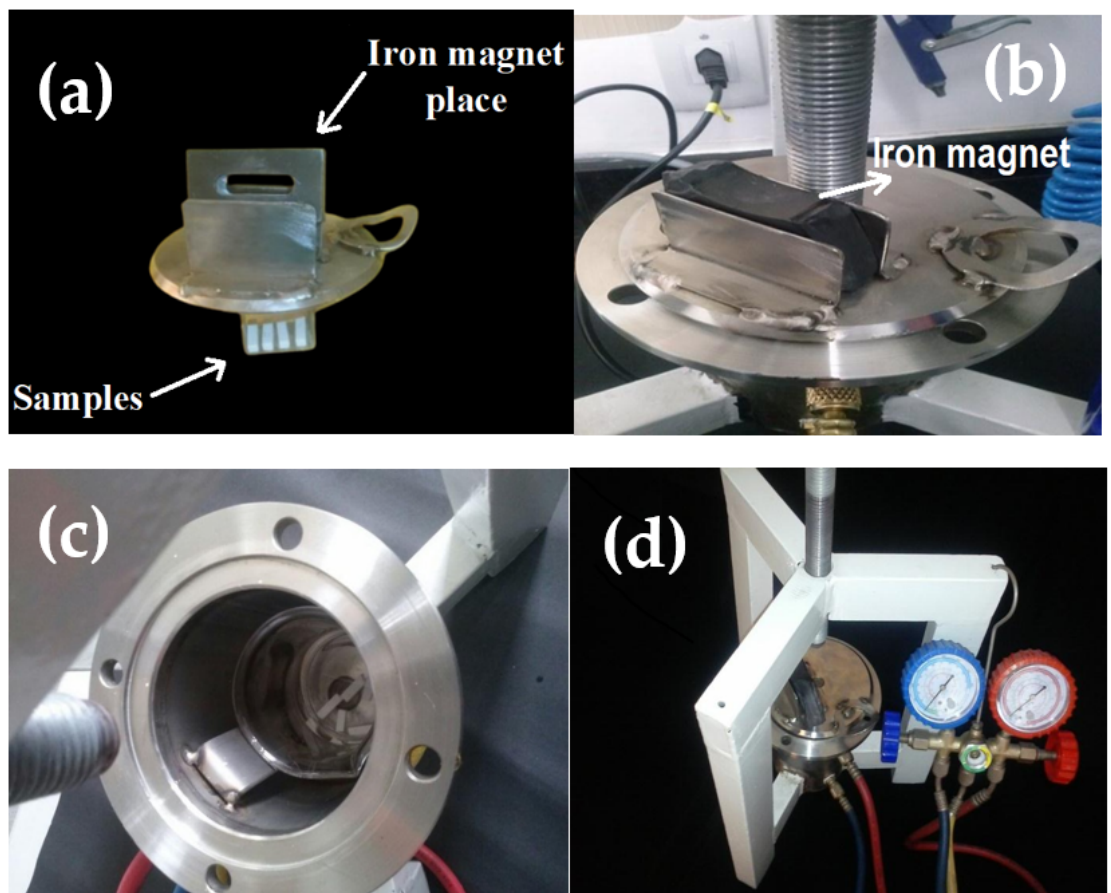
Figure 2. Configuration of the homemade system designed for infiltration of PMMA into the sintered Al 2 O 3 commercial samples. ( a ) A lid of the stainless steel for vacuum chamber above which one iron magnet is placed, ( b ) iron magnet (150 mm × 60 mm × 15 mm; mass = 60 g) put over the lid, ( c ) a stainless steel vacuum chamber (diameter = 170 mm, height = 230 mm and thickness = 6 mm) inside which a beaker and samples are shown, and ( d ) the whole configuration of infiltration system connected to vacuum pressure adjustment. Table 1. Summary of conditions for preparation of samples, infiltration time and the estimated amount of PMMA (vol.%) infiltration.